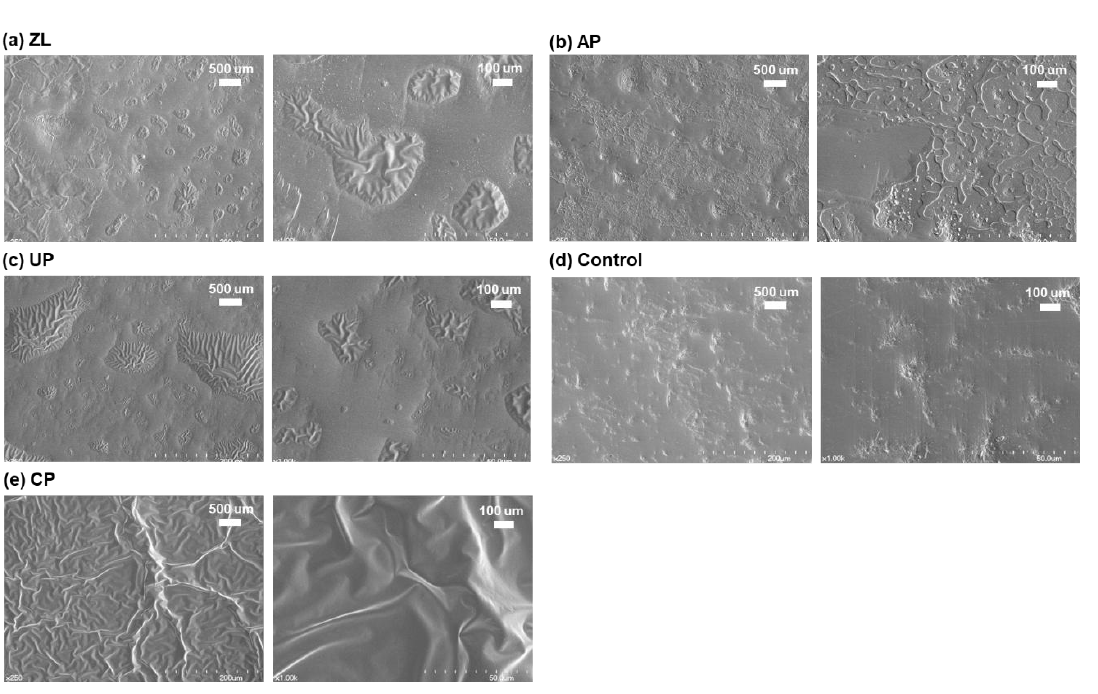
Figure 3. SEM images of zirconia surfaces primed with: ( a ) ZL: zicornia liner; ( b ) AP: alloy primer; ( c ) UP: universal primer; ( d ) control: no primer; ( e ) CP: catechol